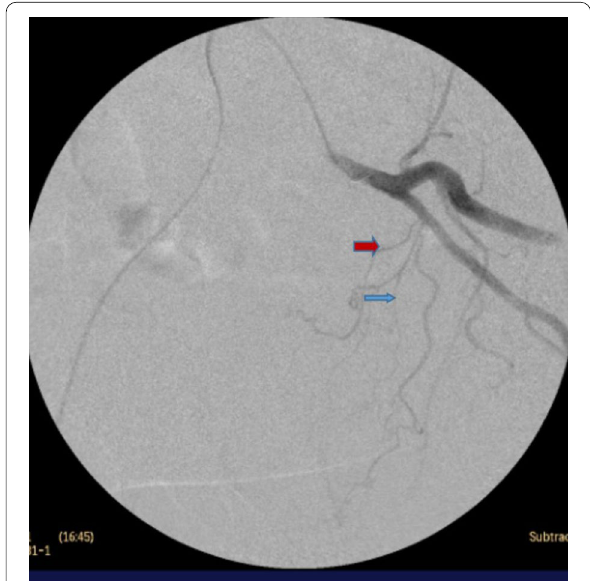
Fig. 1 Angiography image, showing double prostatic arteries for left side, common origin with superior vesical artery (blue arrow) and separate origin of superior vesical artery (red arrow)